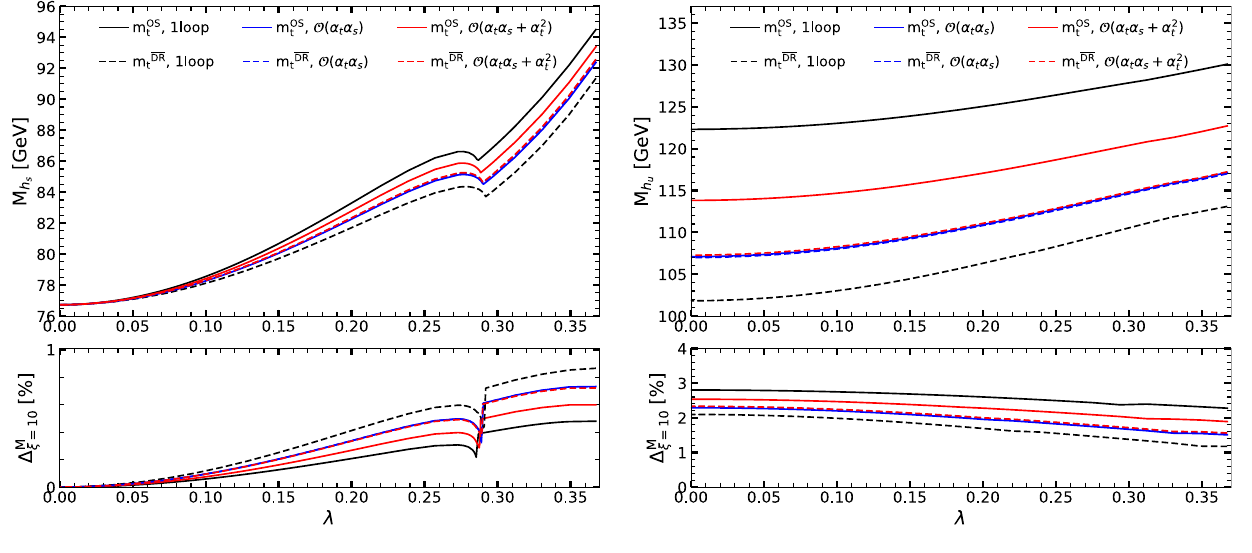
Higgs boson mass vanish in this limit. Therefore all lines in the left plots converge at the left endpoint where λ ≈ 0.